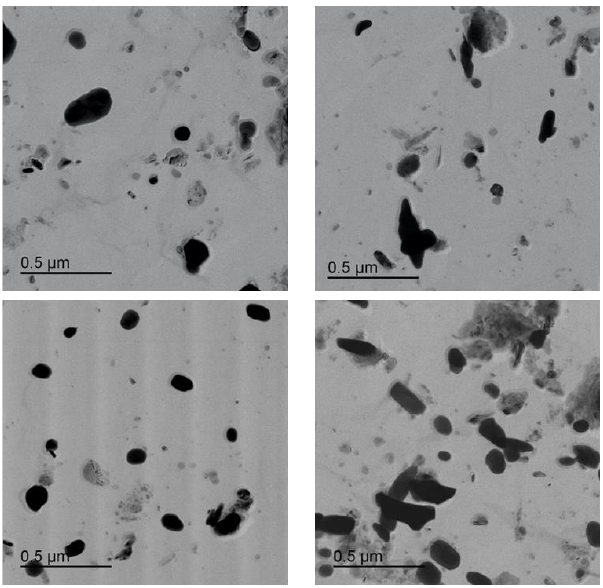
Figure A15. Failed crept cross-weld specimen 92-HAZ-6-6 650 °C 65 MPa 3877 h (sample H). TEM images on a carbon extraction replica at 100,000X.